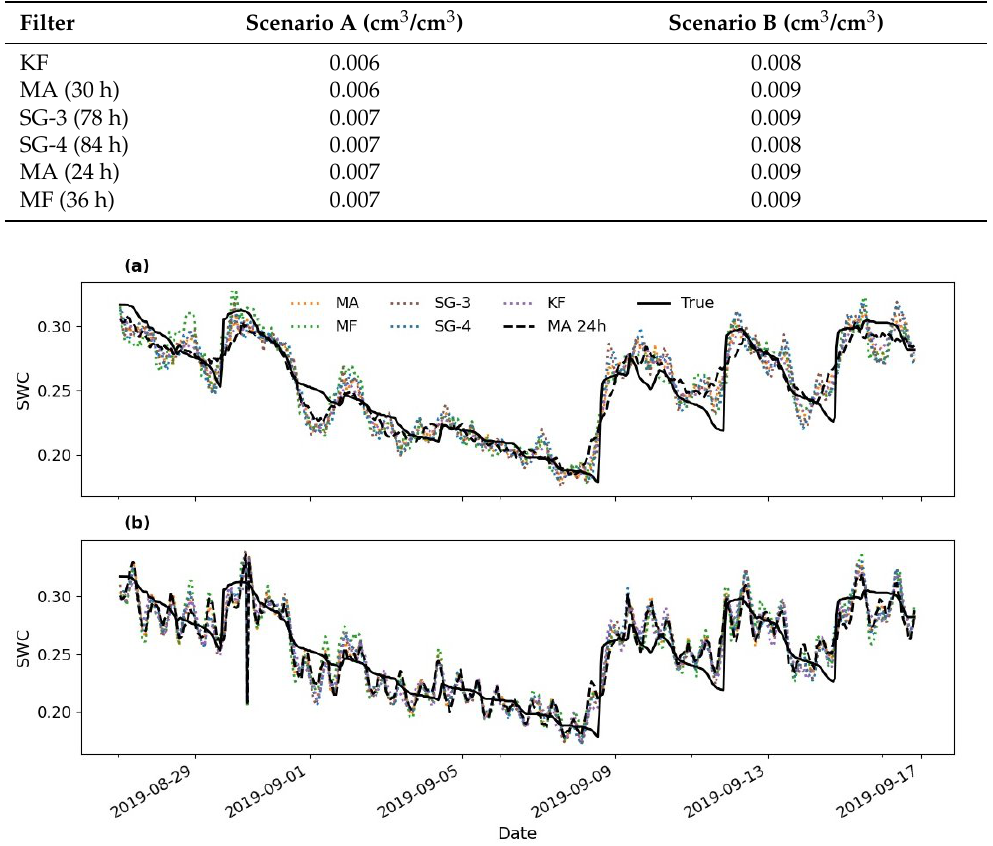
Table 4. RMSE comparison of scenarios A and B regarding soil moisture uncertainty reduction.